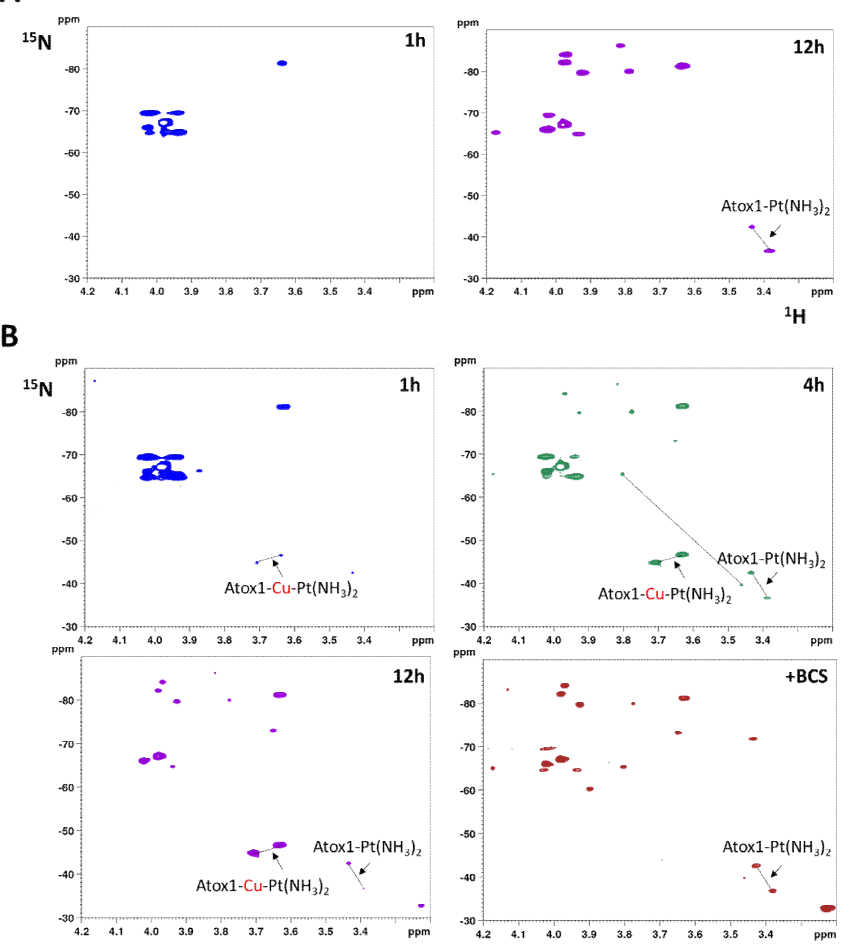
Figure 5. ( A ) Two-dimensional 1 H, 15 N-HSQC spectra of 15 N-labeled cisplatin recorded at two different time intervals after mixing with one equivalent of reduced apo Atox1 (70 µM) in 25 mM phosphate buffer (pH 7.0), in the presence of EDTA (210 µM). ( B ) Two-dimensional 1 H, 15 N-HSQC spectra of 15 N-labeled cisplatin recorded at different time intervals after mixing with one equivalent of Cu(I)-Atox1 (70 µM) in 25 mM phosphate buffer (pH 7.0), in the presence of GSH (210 µM) and EDTA (210 µM). After 12 h of incubation, bathocuproine disulfonate (BCS) was added.